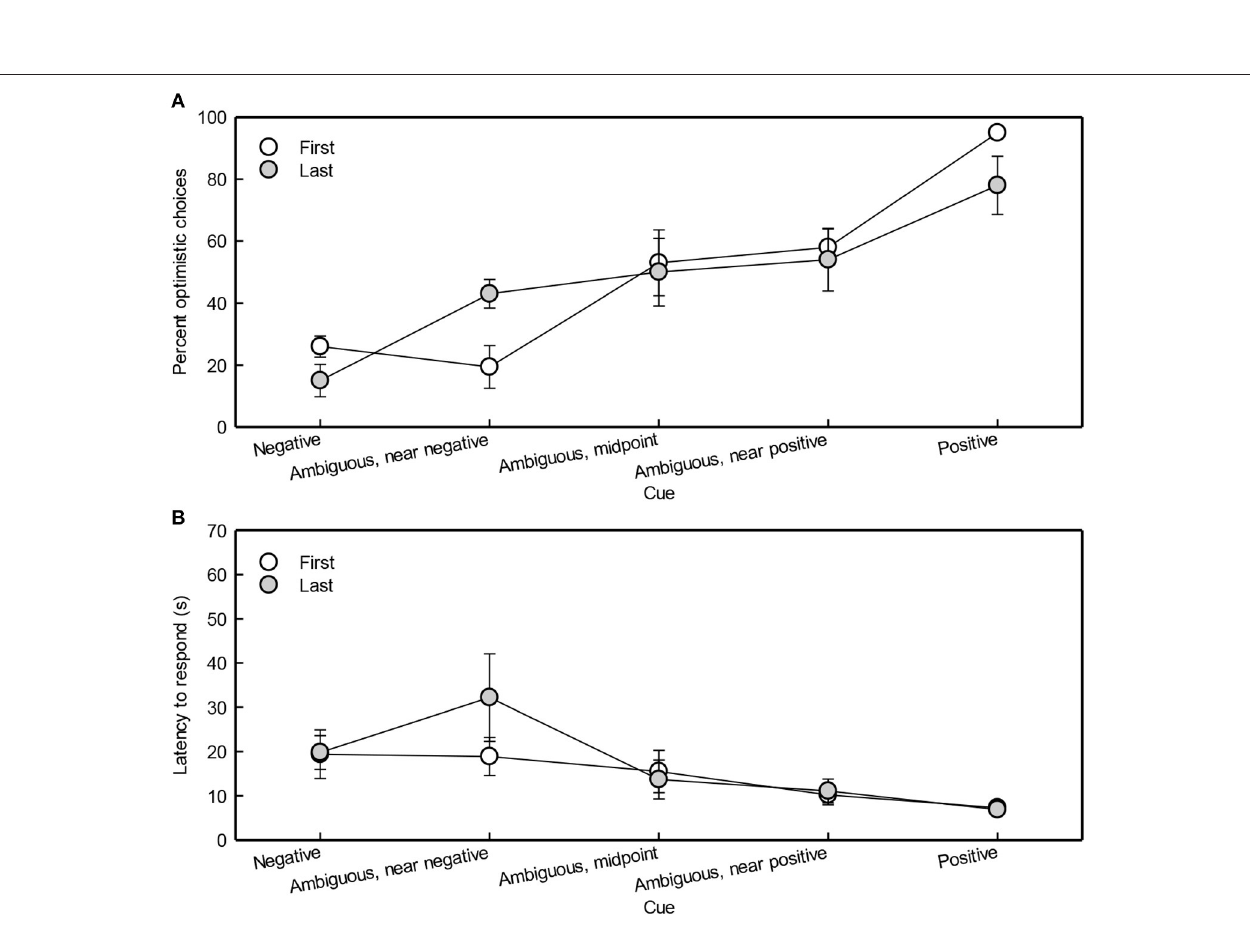
Frontiers in Animal Science |